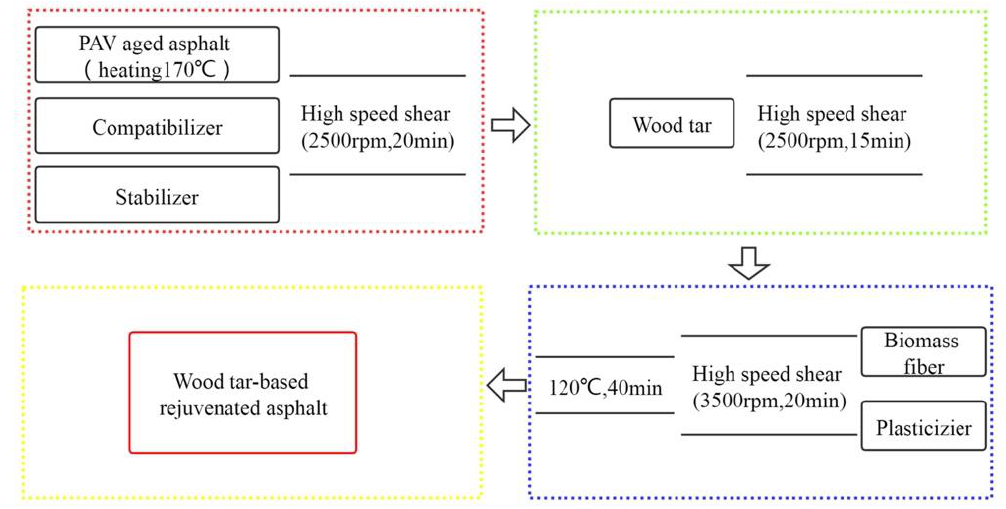
Figure 2. Preparation process of wood tar-based rejuvenated asphalt.